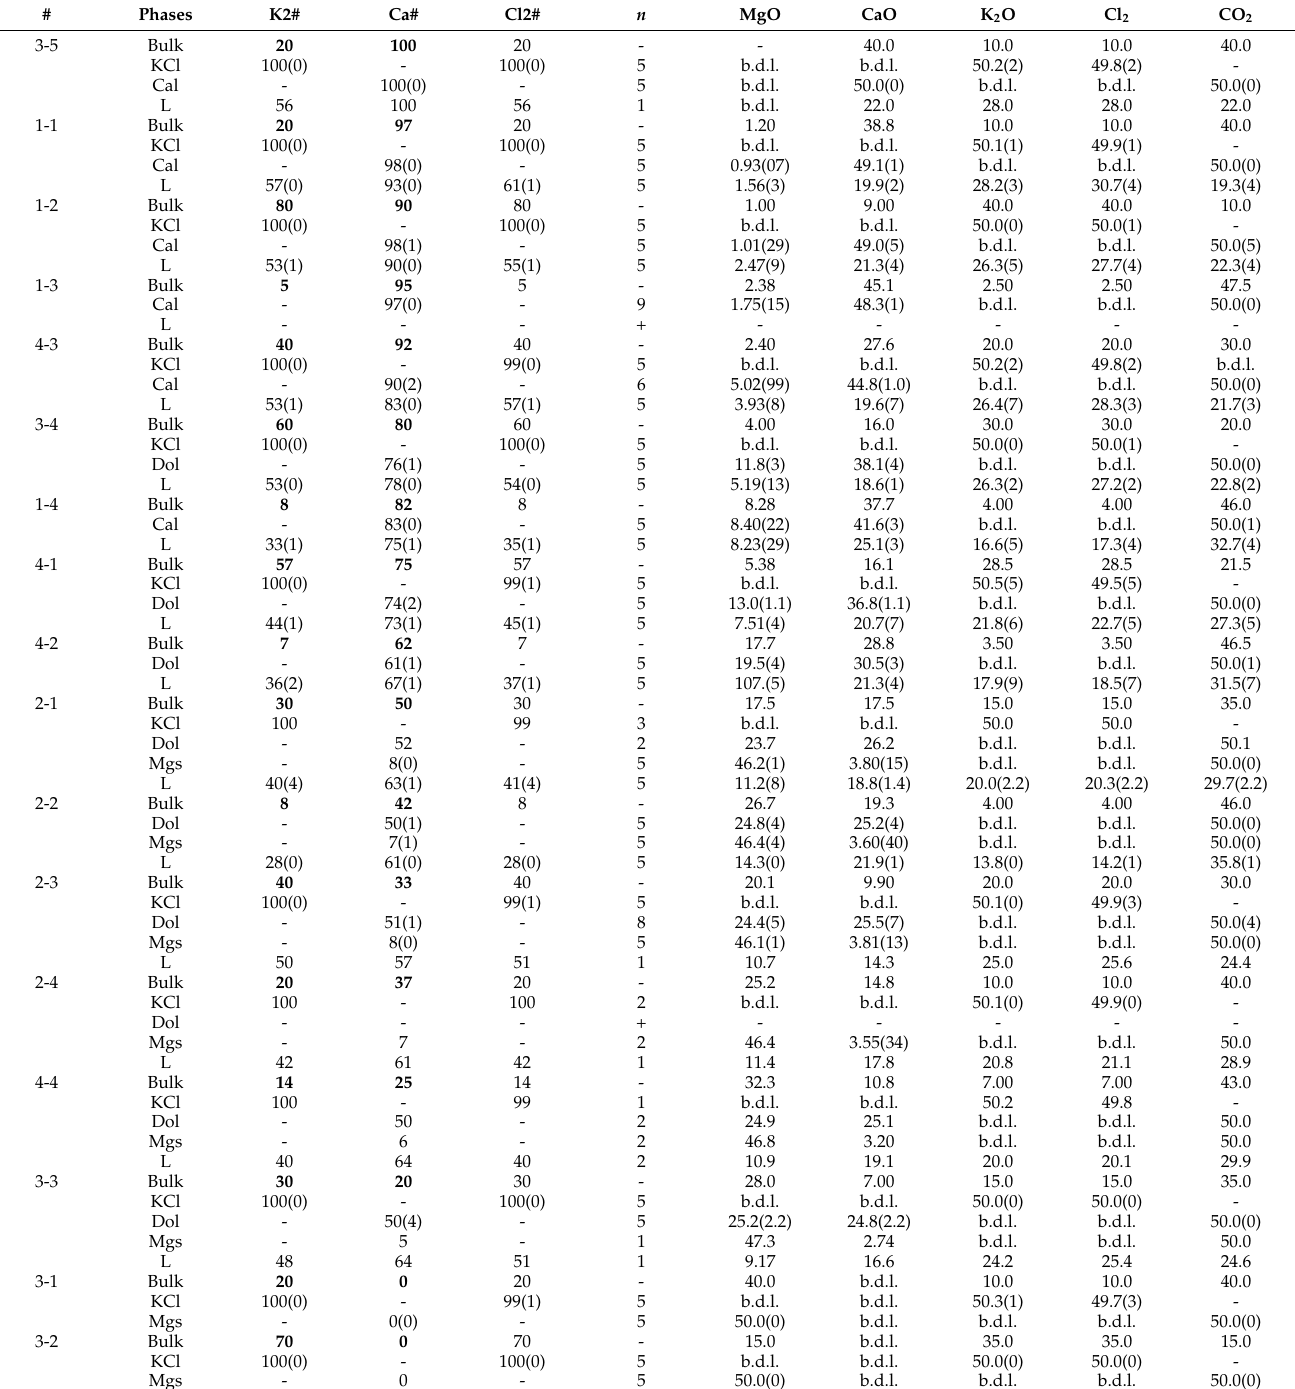
Table 2. Phase compositions (mol%) in run D310 at 1000 ◦ C and 24